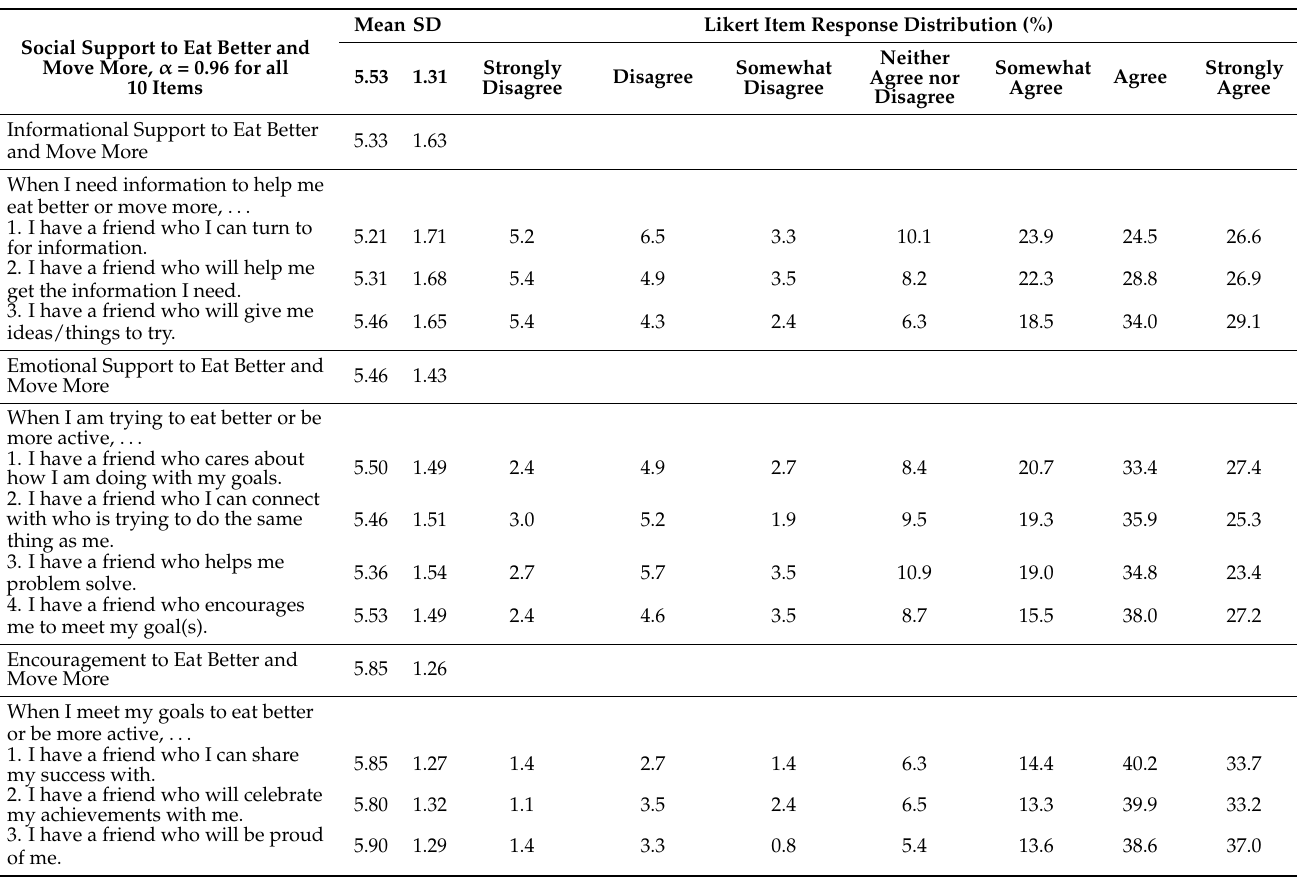
Table 2. Reliability and descriptive data for information, emotional and encouragement social support to eat better and move more.